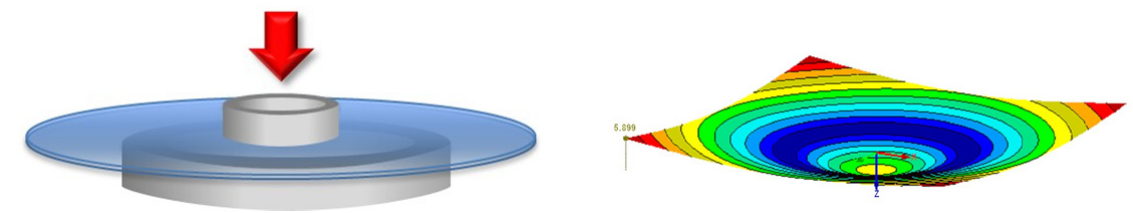
Fig. 4 Ring on ring test set-up, deformation of glass